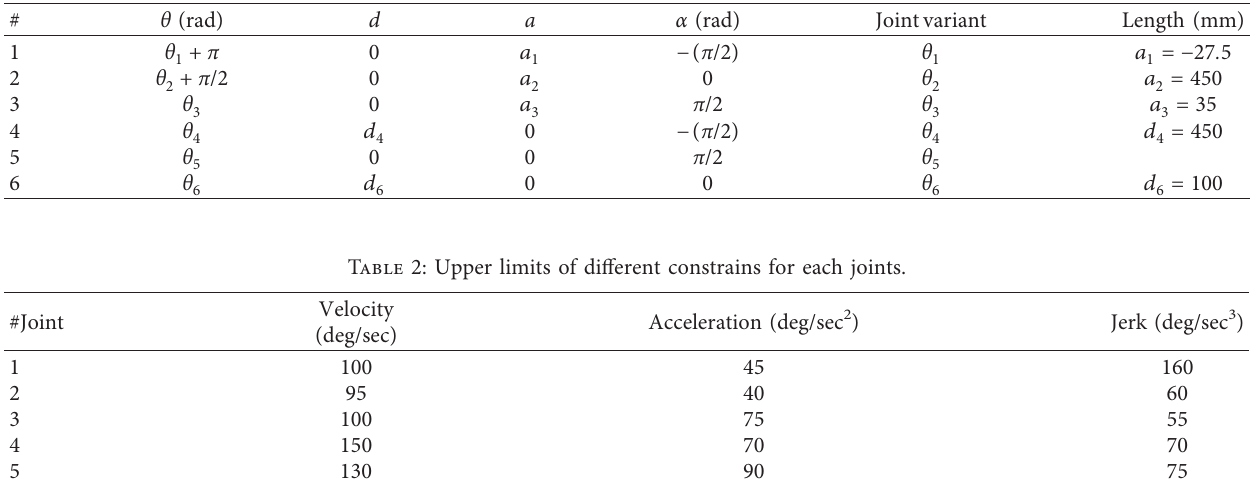
Table 1: DH parameters of STR6-05.